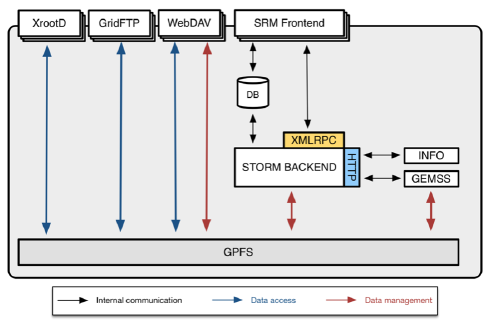
Figure 1. The StoRM high level